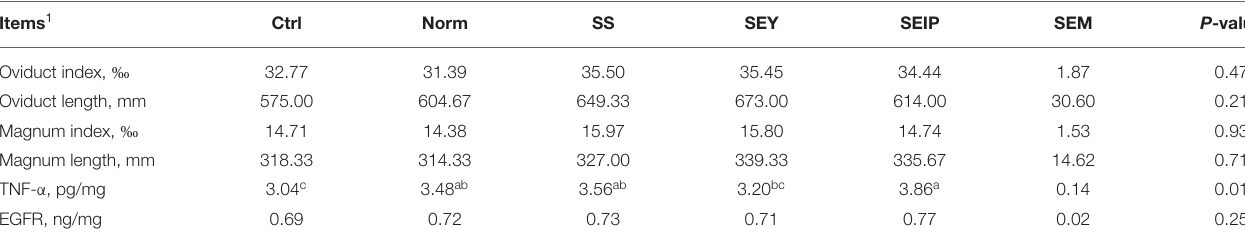
TABLE 9 | Effects of dietary Se sources on the oviduct of laying